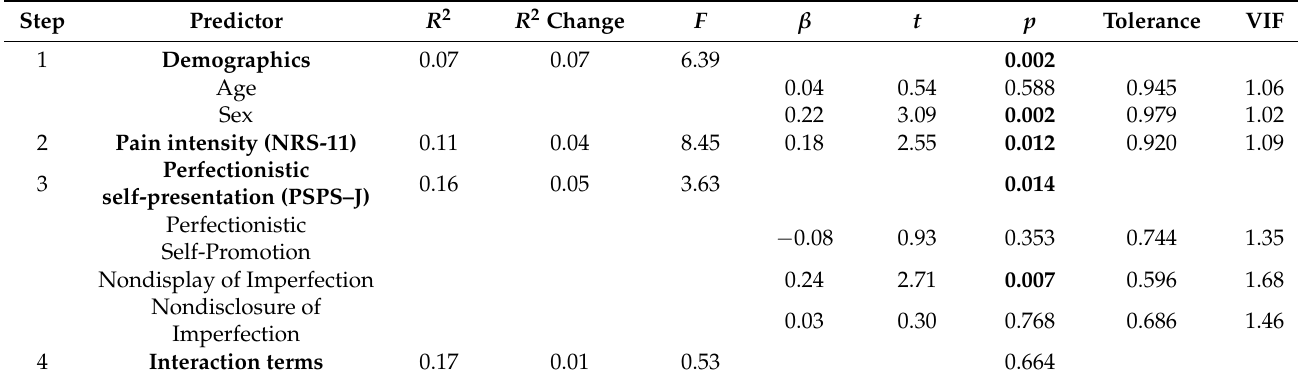
Table 7. Regression analysis explaining fatigue (PROMIS-P-25).